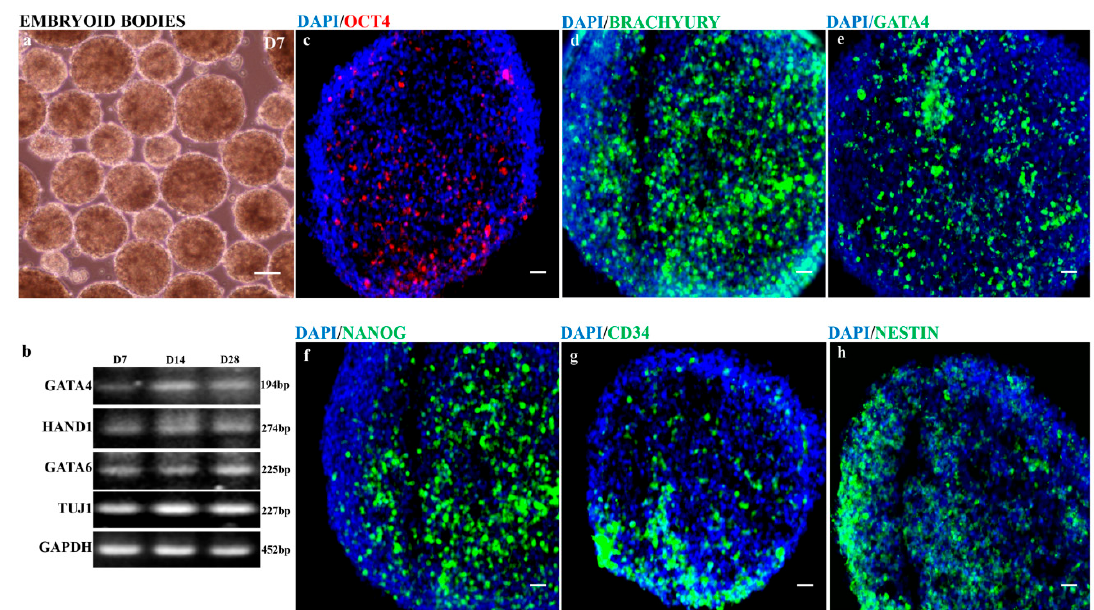
Figure 3. hiPSC-derived free-floating embryoid bodies (EBs) exhibit germ layers. ( a ) Suspension culture of embryoid bodies at day 7; ( b ) reverse-transcription PCR analysis revealed the consistent expression of mesoderm ( HAND1 and GATA6 ), endoderm ( GATA4 ), ectoderm ( TUJ1 ), & internal control ( GAPDH ) markers for at different stages of EBs (days 7, 14 and 28); and ( c – h ) immunohistochemistry staining of cryosectioned EBs at day 7 showed the expression of pluripotency ( OCT4 and NANOG ), mesoderm ( BRACHYURY and CD34 ), endoderm ( GATA4 ) and ectoderm ( NESTIN ) markers. Scale bars, 50 µ m ( c – h ); 100 µ m ( a ).